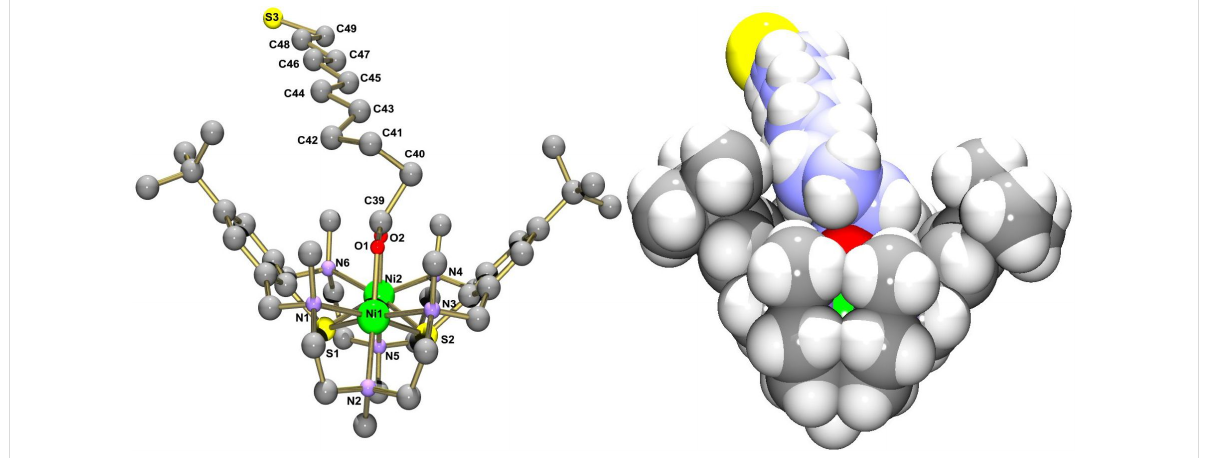
Figure 3: Ball and stick (left) and van der Waals representations (right) of the molecular structure of the [Ni 2 L(O 2 C(CH 2 ) 10 SH)] + cation in crystals of 7 .